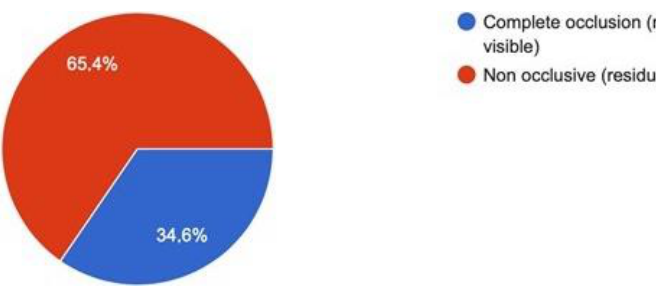
Figure 2. Grade of occlusion of the portal system.